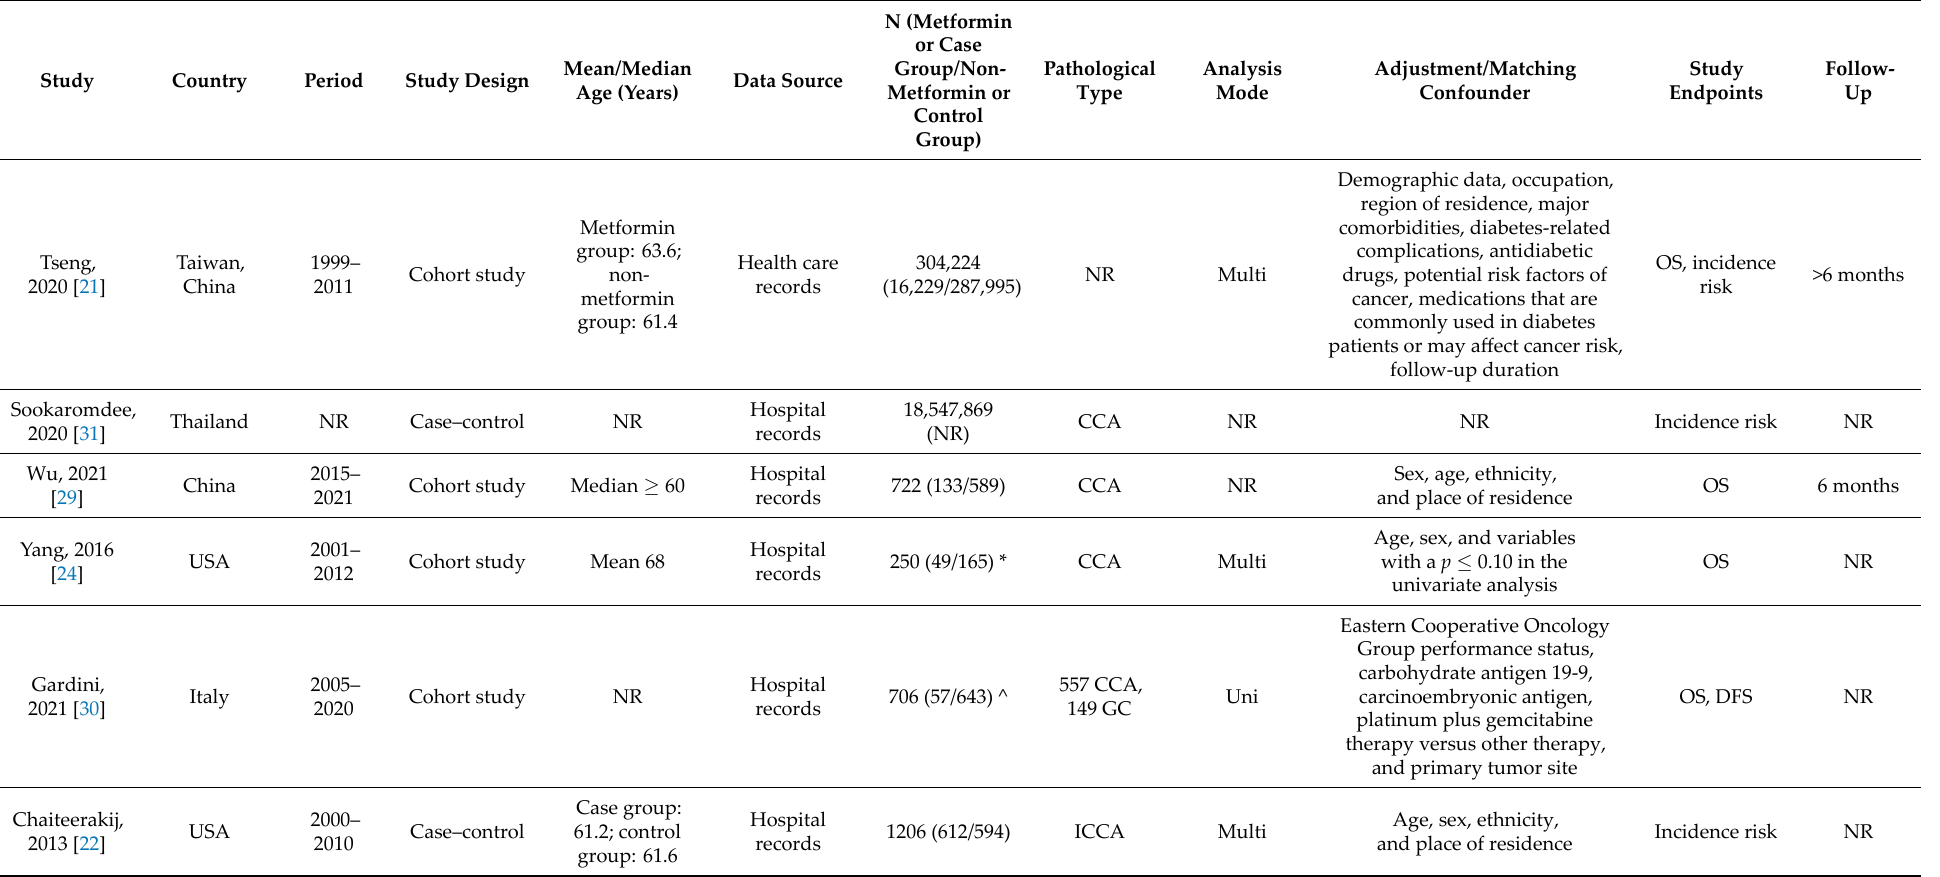
Table 1. Characteristics of studies investigating the effects of metformin on biliary tract